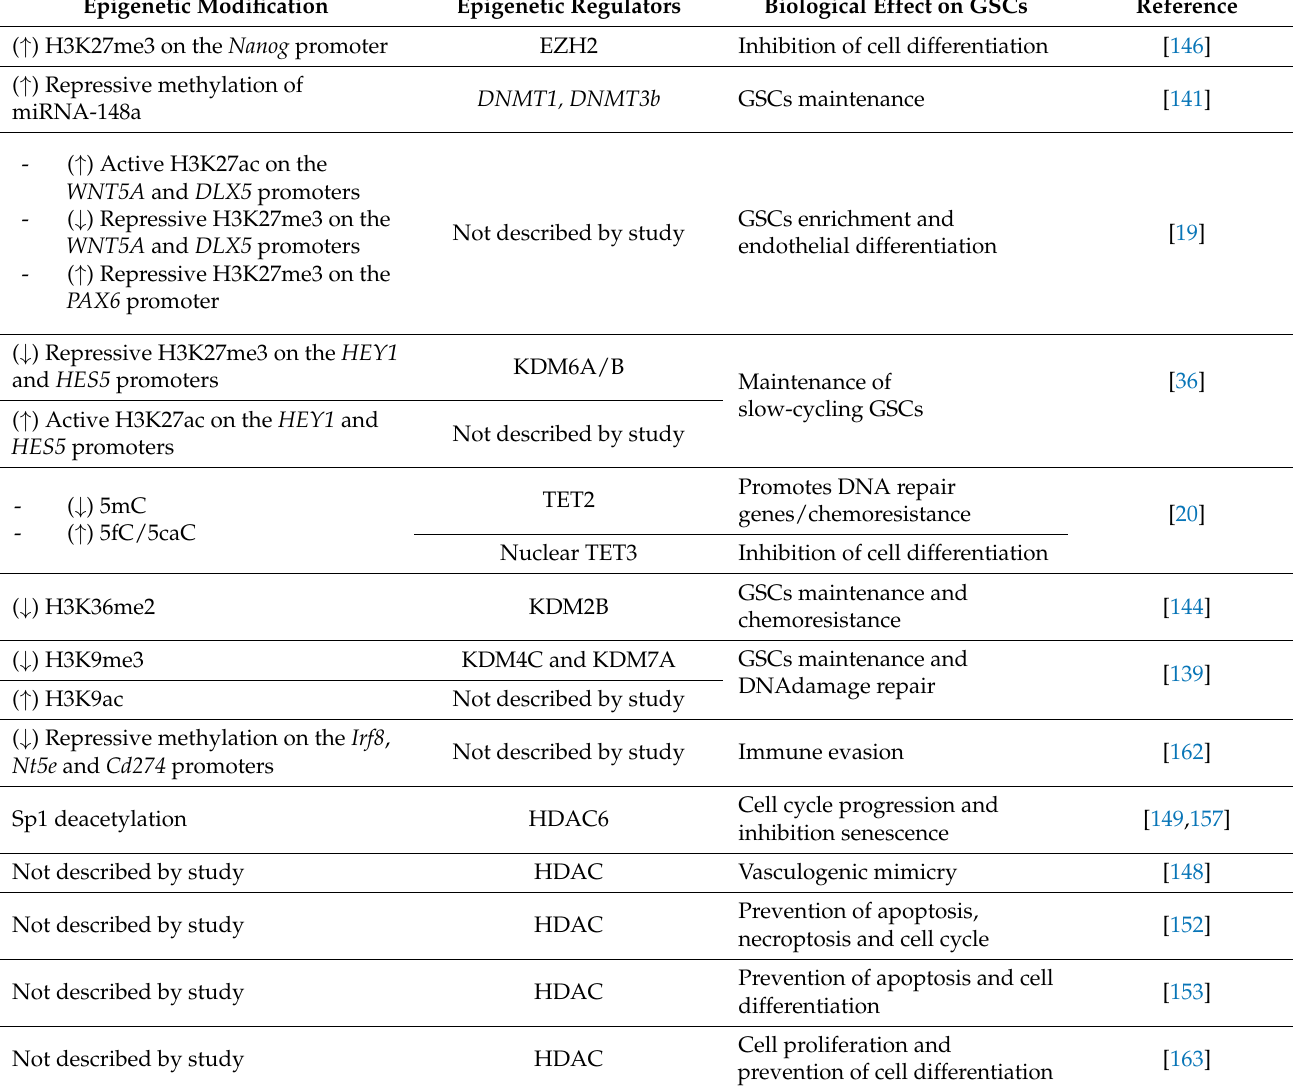
Table 1. Epigenetic modifications and its role in regulating the GSCs